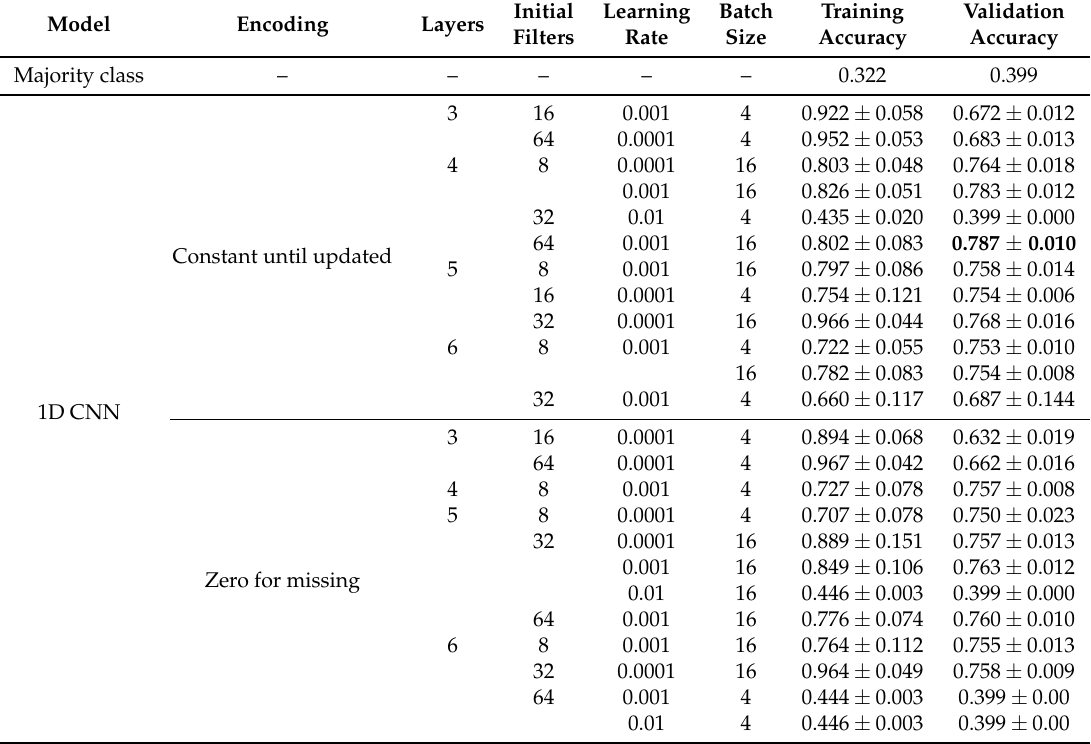
Table A6. 1D CNN hyperparameter tuning. Due to the large search space, 24 sets of hyperparameters were randomly sampled from the grid of options, and each set was trained with 5 random CNN weight initializations and bootstrapped training sets to obtain error bars (shown for 1 standard deviation).